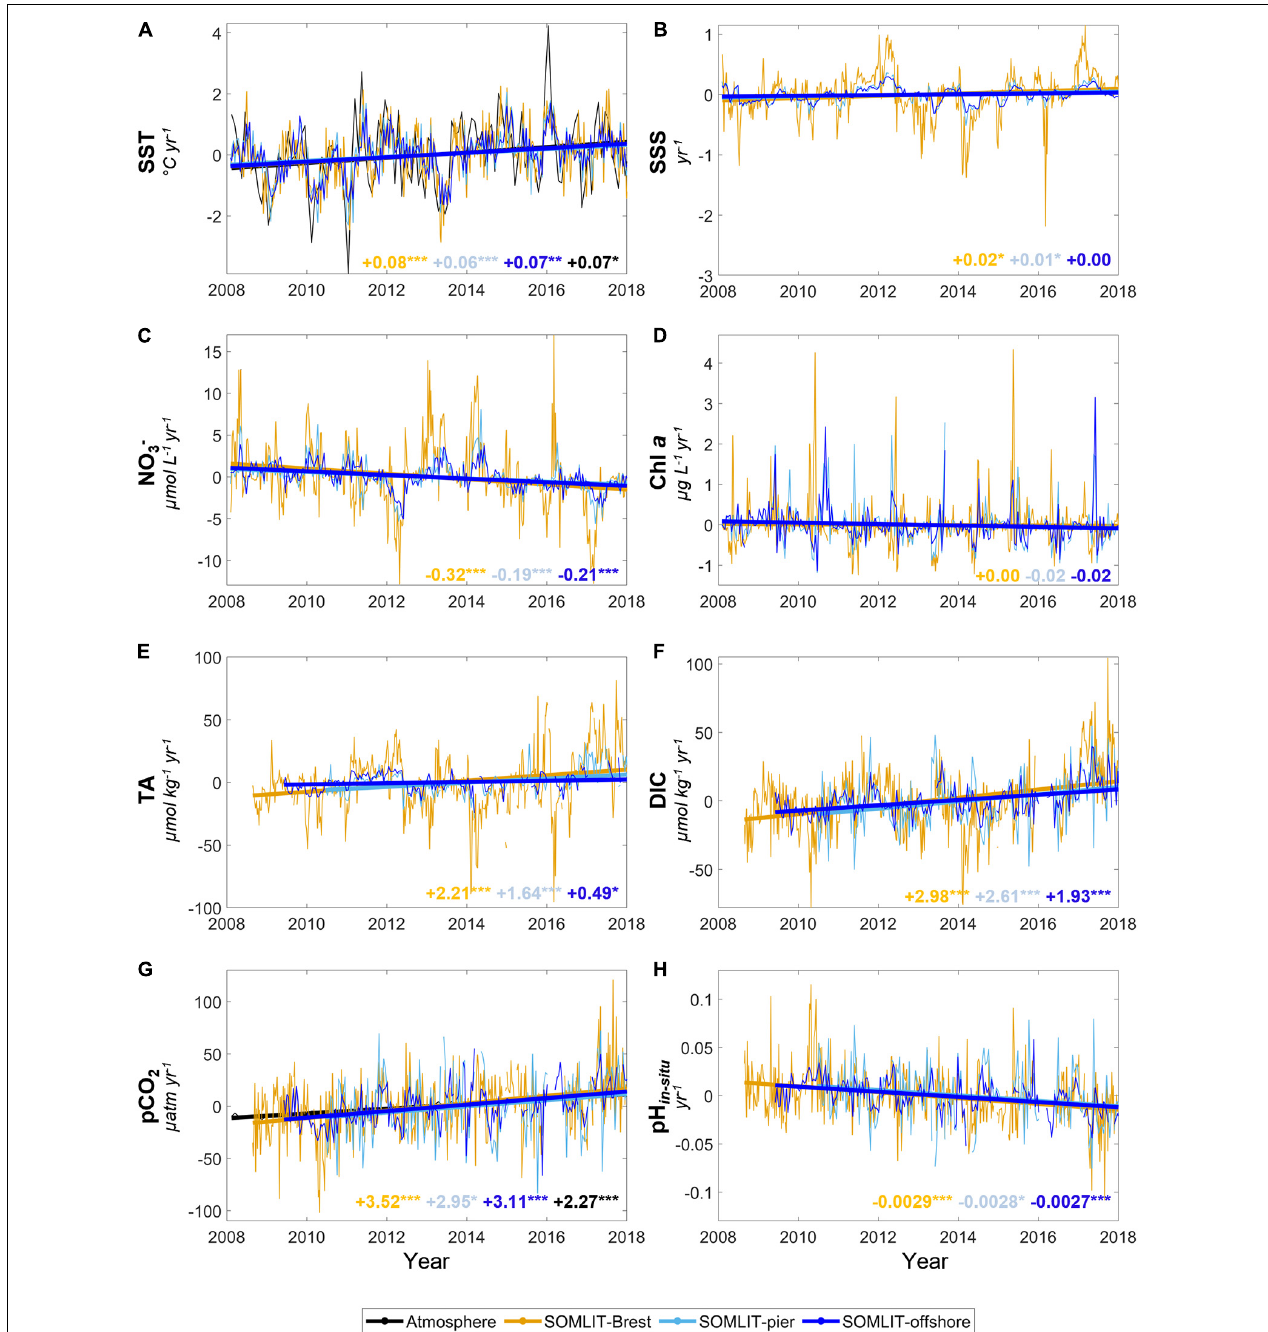
FIGURE 5 | Trends of monthly anomalies of (A) SST ( ◦ C year − 1 ), (B) SSS (year − 1 ), (C) nitrate ( µ mol L − 1 year − 1 ), (D) Chl a ( µ g L − 1 year − 1 ), (E) TA ( µ mol kg − 1 year − 1 ), (F) DIC ( µ mol kg − 1 year − 1 ), (G) pCO 2 ( µ atm year − 1 ), and (H) pH in situ (year − 1 ) at SOMLIT-Brest (orange), SOMLIT-pier (light blue), and SOMLIT-offshore (dark blue) for January 2008 to December 2017 (see Section “Weekly and Bimonthly Measurements of the Long-term Time-Series” for details on starting dates of sampling). The black lines (A,G) represent the monthly anomaly of atmospheric temperature ( ◦ C year − 1 ) and pCO 2 atm ( µ atm year − 1 ). The asterisks represent the p -values: *** p -value < 0.001, ** p -value < 0.01, * p -value < 0.05, and no asterisk indicates non-significant